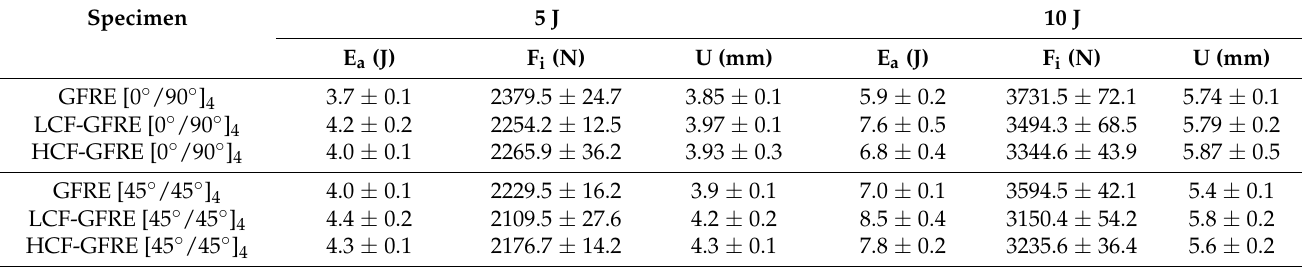
Table 3. Low impact velocity test results for all laminates at impact energy of 5 J and 10 J.